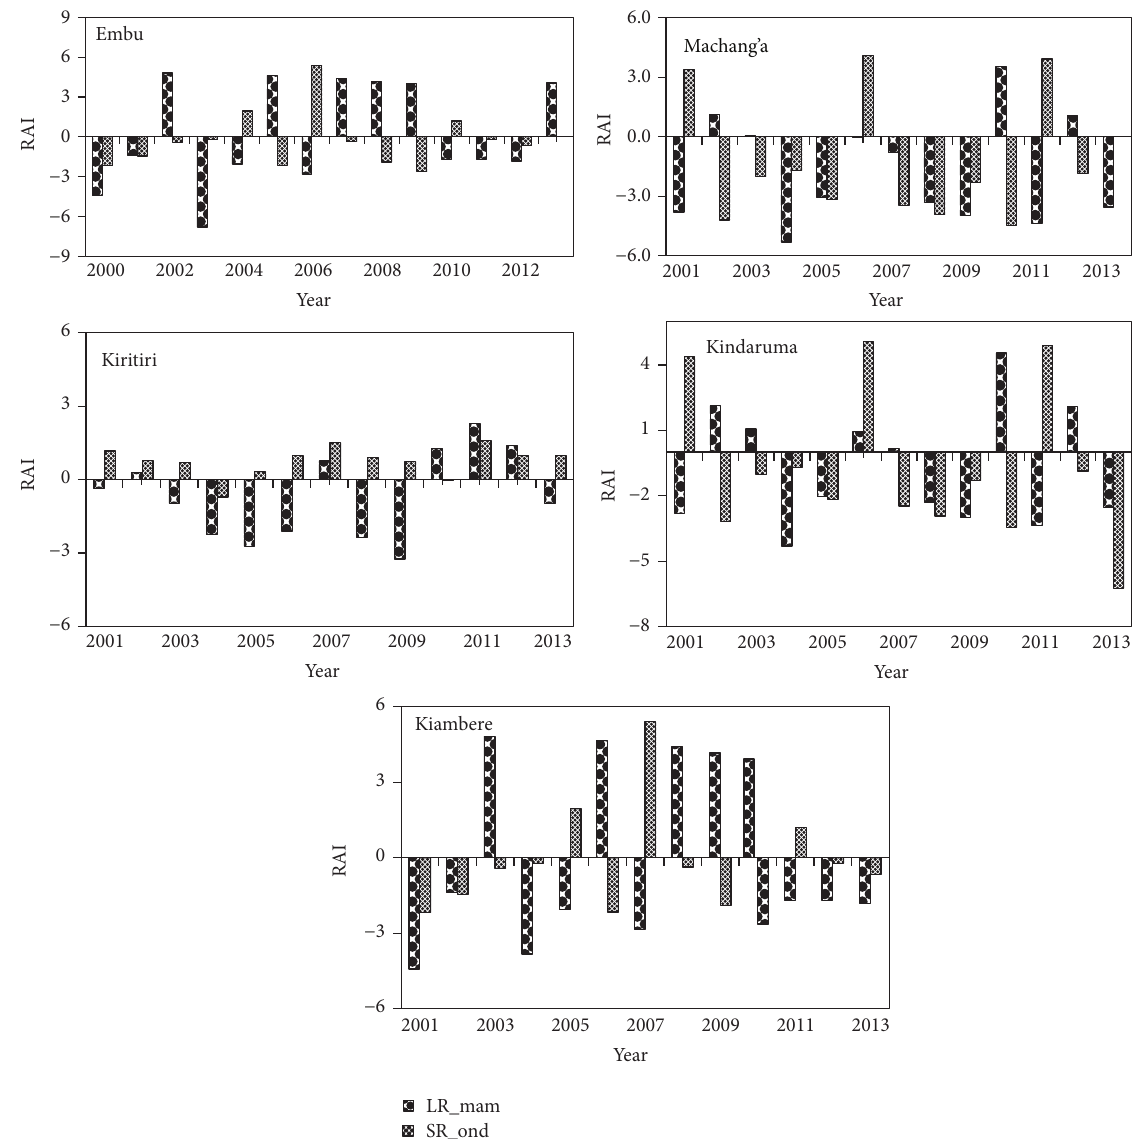
Figure 4: Decadal rainfall anomaly index for both LR MAM and SR OND in Embu, Machang’a, Kiritiri, Kindaruma, and Kiambere; RAI: rainfall anomaly